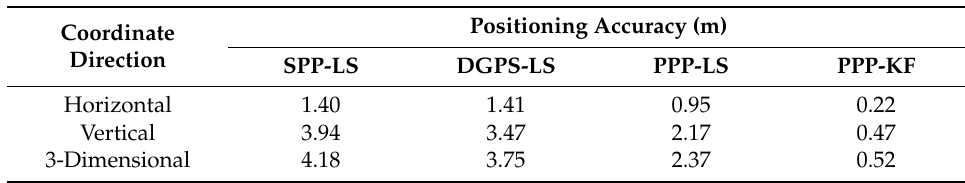
Table 1. Comparison of positioning accuracy using SPP-LS, DGPS-LS, PPP-LS, and PPP-KF. LS and KF indicate the least-squares and Kalman filter, respectively.